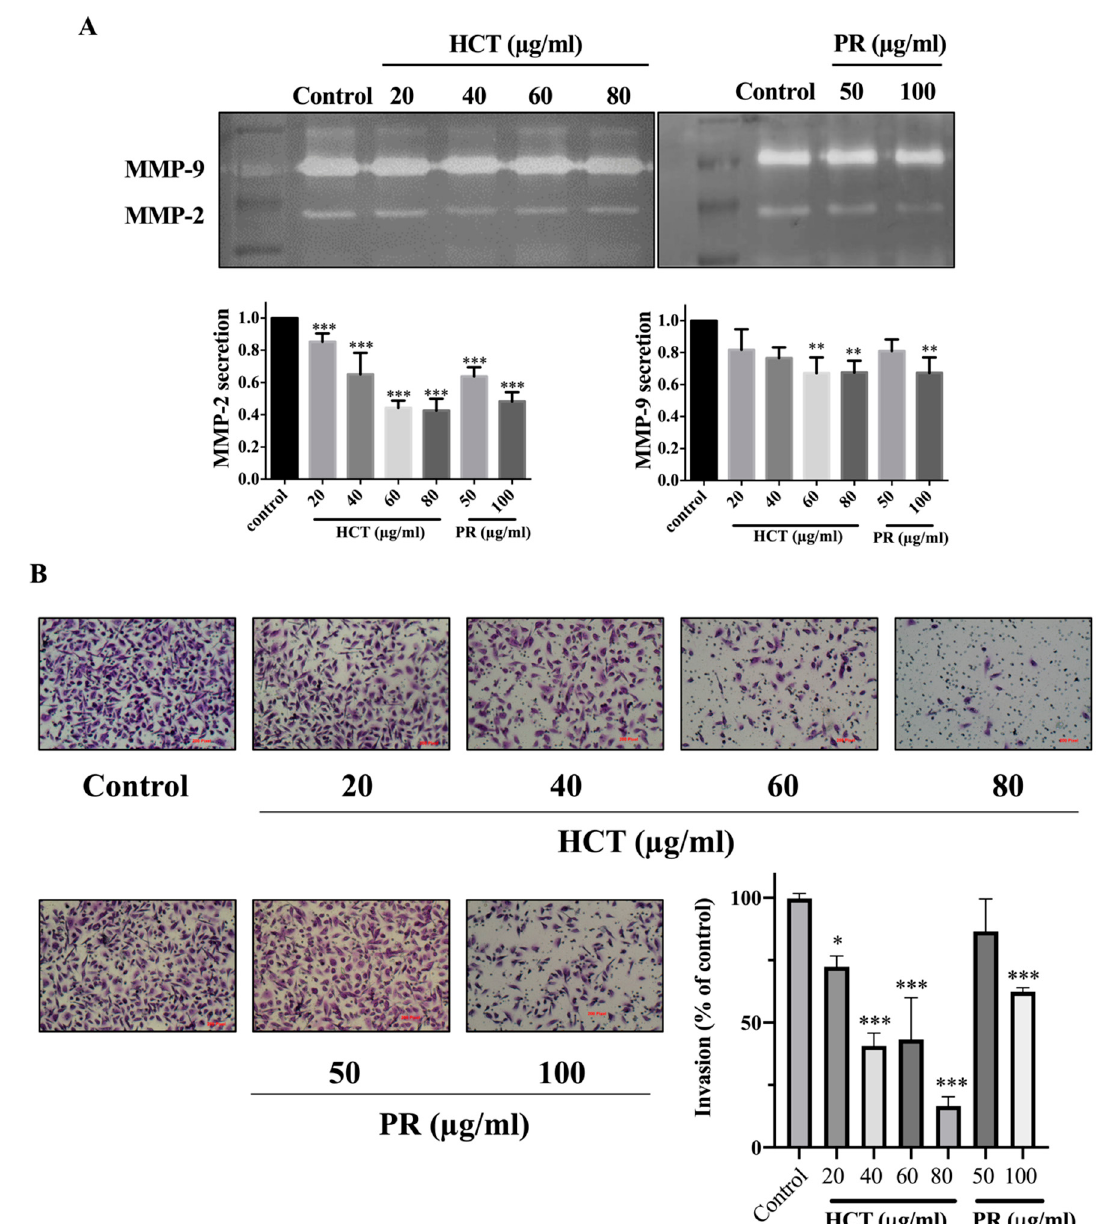
Figure 7. Effect of H. cordata and P. ribesioides extracts on breast cancer cell invasion. MMP-2 and -9 secretions assay ( A ) and invasion assay ( B ) were analyzed. MMP-2 and -9 were quantitated compared with the control. Each value is presented as mean ± SD from three independent experiments. Data are the means ± SD. * p < 0.05, ** p < 0.01, and *** p < 0.001 vs. control.